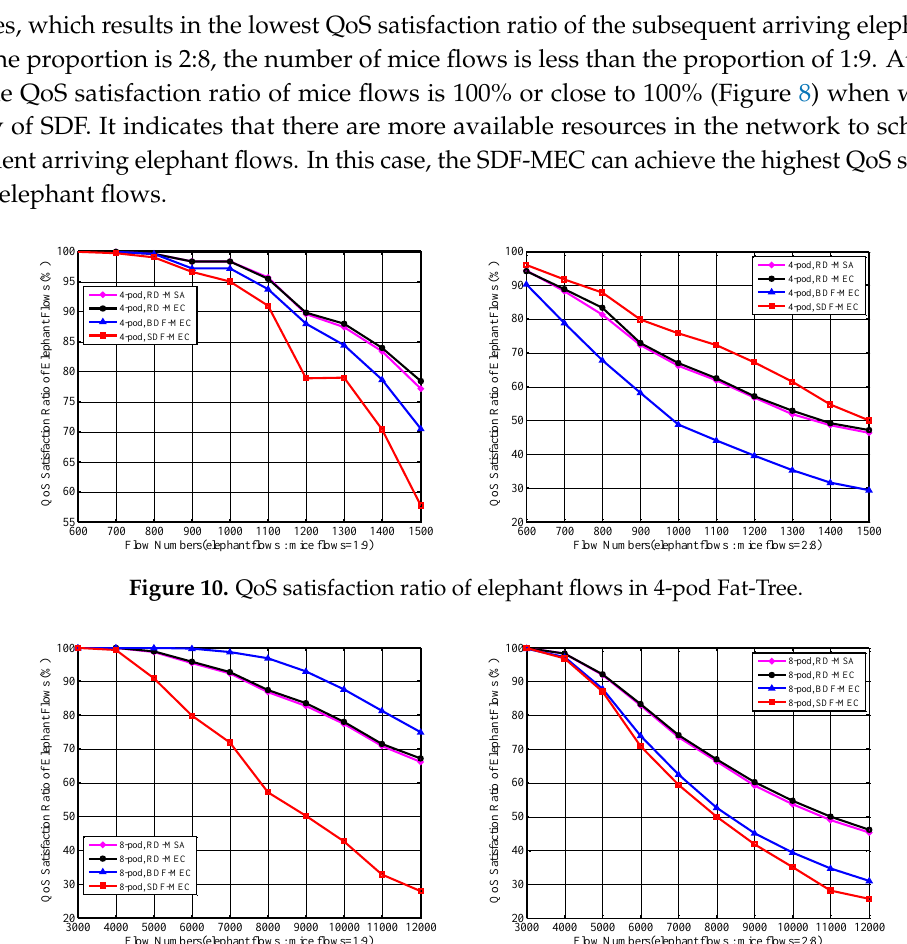
Figure 11. QoS satisfaction ratio of elephant flows in 8-pod